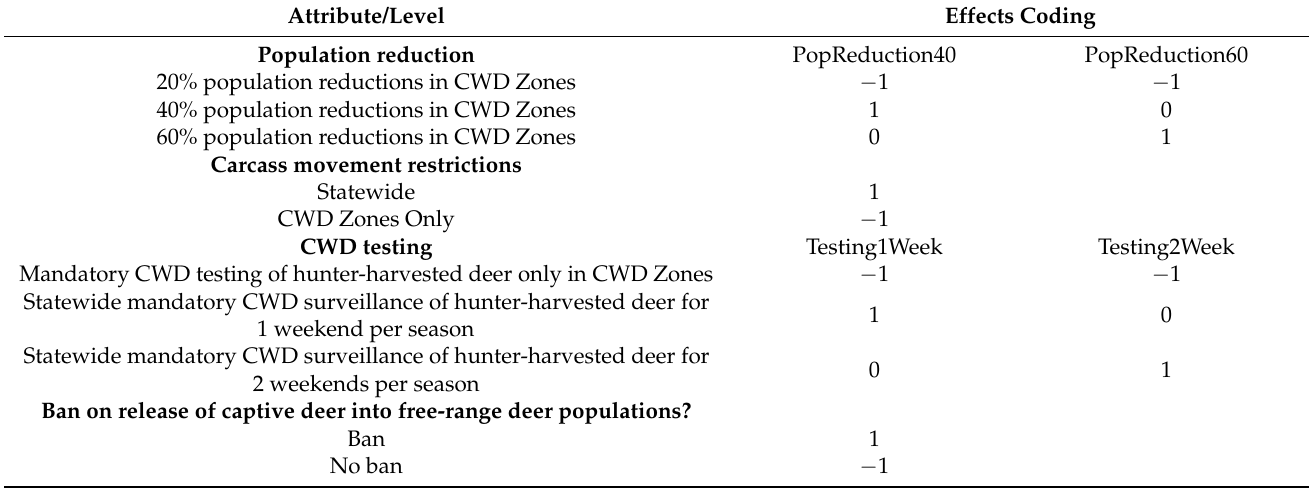
Table 1. Attributes and levels of the choice experiment and effects coding used in logit model analysis of Texas hunter CWD management